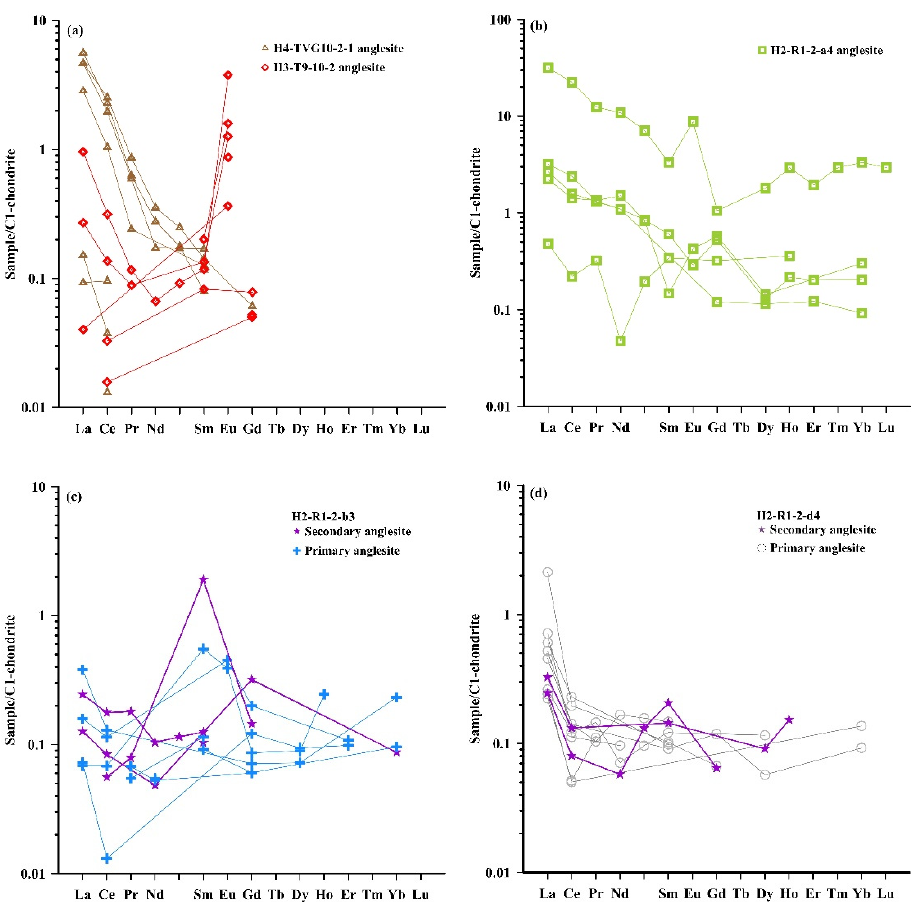
Figure 9. REE patterns of anglesite in samples ( a ) H4-TVG10-2-1 and H3-T9-10-2; ( b ) H2-R1-2-a4; ( c ) H2-R1-2-b3; and ( d ) H2-R1-2-d4 (Normalized data from Sun and McDonough, [53]). H2-R1-2-b3; and ( d ) H2-R1-2-d4 (Normalized data from Sun and McDonough,